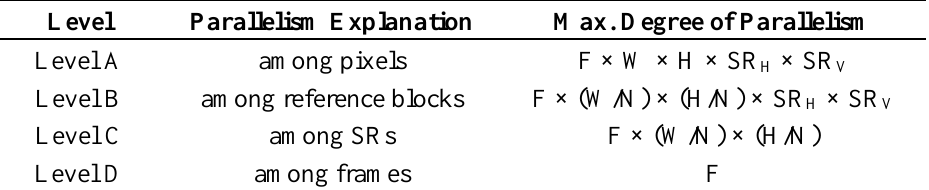
Figure 3. Four different levels of parallelism for FSIME. Table 2. Different Parallelism